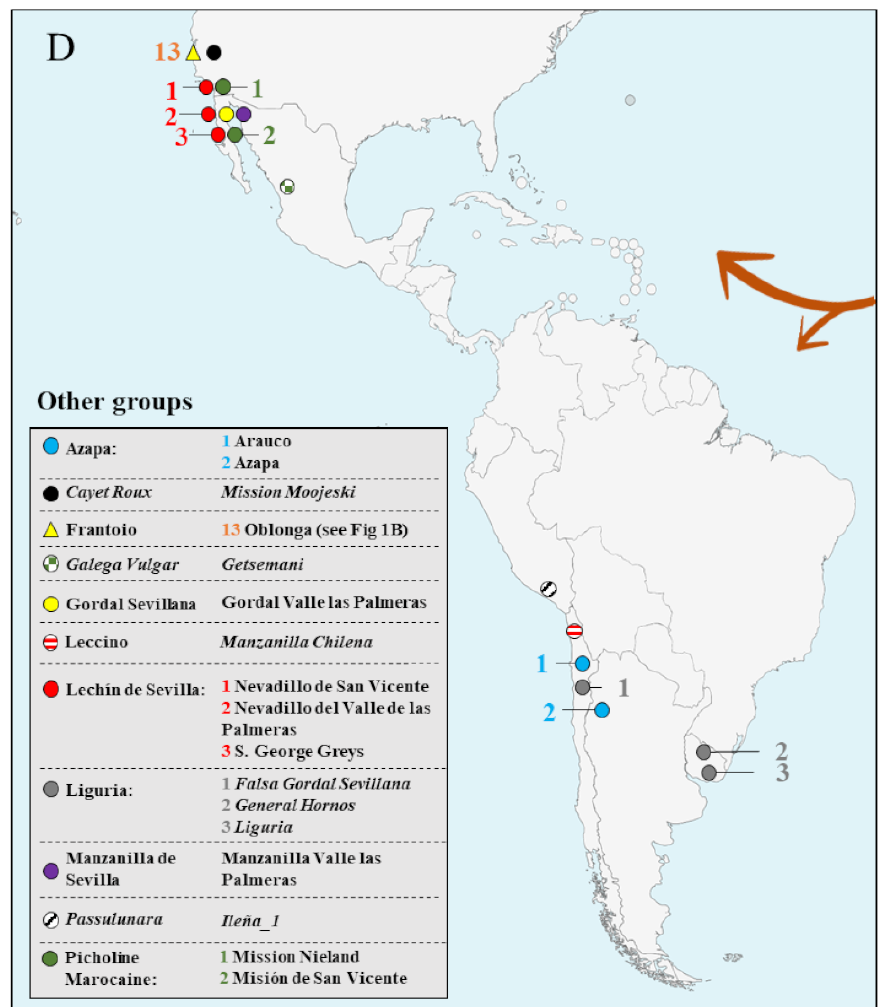
Figure 1. Geographical areas of distribution of the synonymy cases included in the biggest redun- dancy groups of “Baladi” ( A , green squares), “Frantoio” ( B , yellow triangles), and “Safrawi” ( C , blue diamonds) in the Mediterranean basin ( A – C ), as well as synonyms found in America ( D , circles in different colours). Accessions within each group are presented alphabetically and numbered accordingly. Italics indicate new observed synonymy